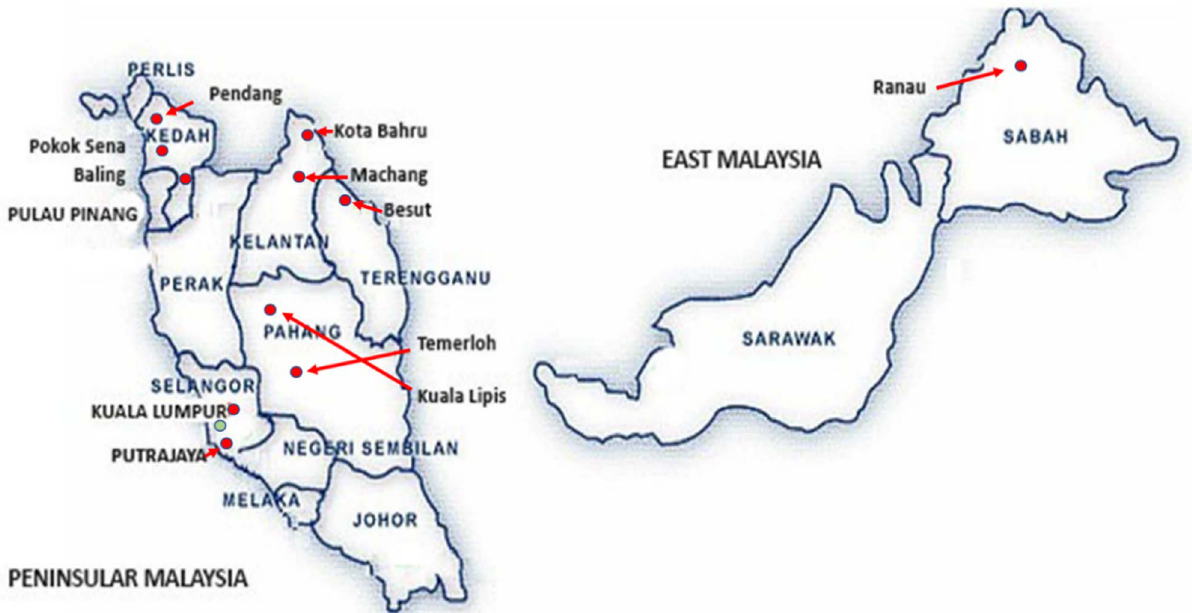
Figure 1. Map of Malaysia showing the study sites marked with red dots. Twelve localities were selected due to the presence of human- macaque co-habitation as well as areas with a high number of malaria cases and neighboring